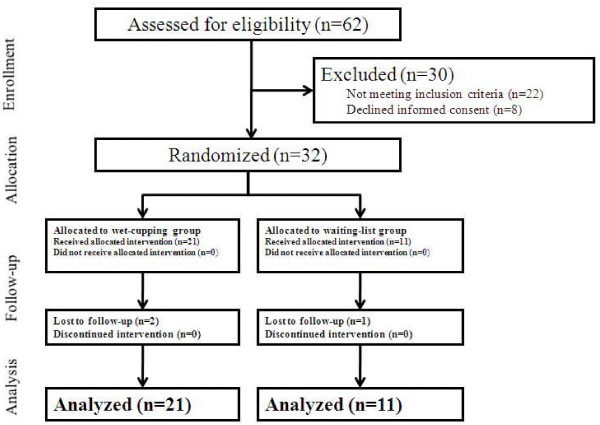
The CONSORT flow chart.